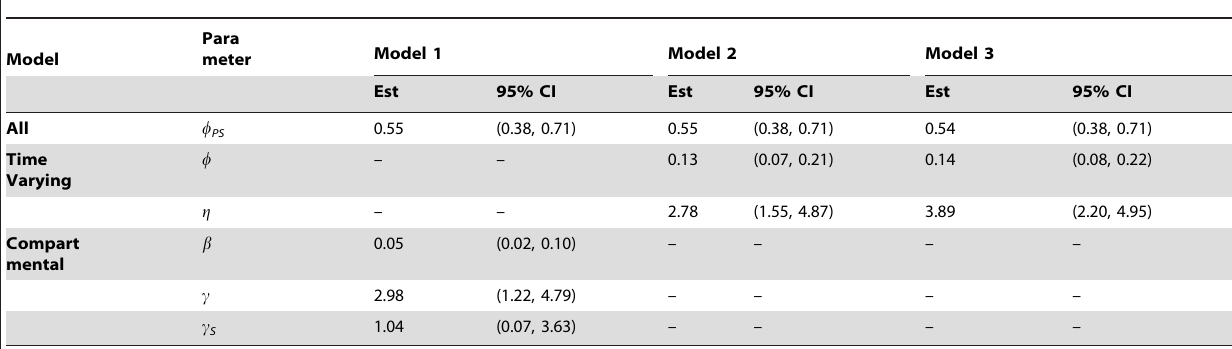
Table 2. Parameter estimates for Models